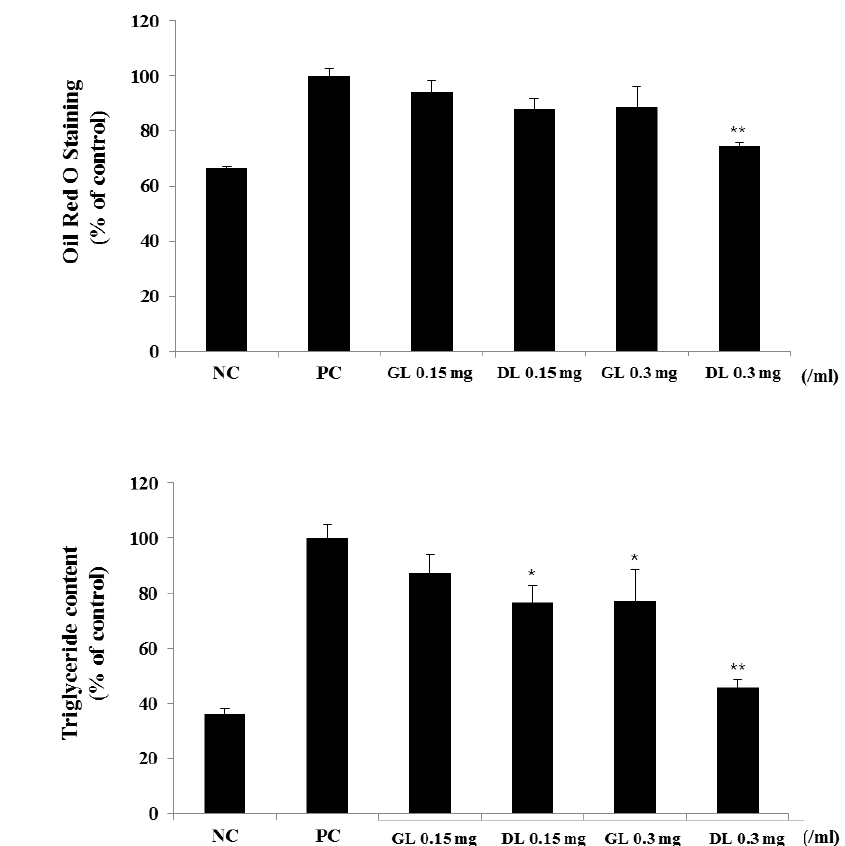
Figure 5. Effects of GL and DL on the differentiation and lipid accumulation of 3T3-L1. 3T3-L1 preadipocytes were treated with GL and DL for eight days, or left untreated (NC). ( A ) The absorbance of cells stained by Oil Red O was measured at 495 nm; and ( B ) intracellular triglyceride concentrations were calculated from measurement of the absorbance at 570 nm. Significant differences from the positive control group (PC), ** p < 0.01 or * p < 0.05, are indicated. Bars represent means ± SD from three independent experiments.